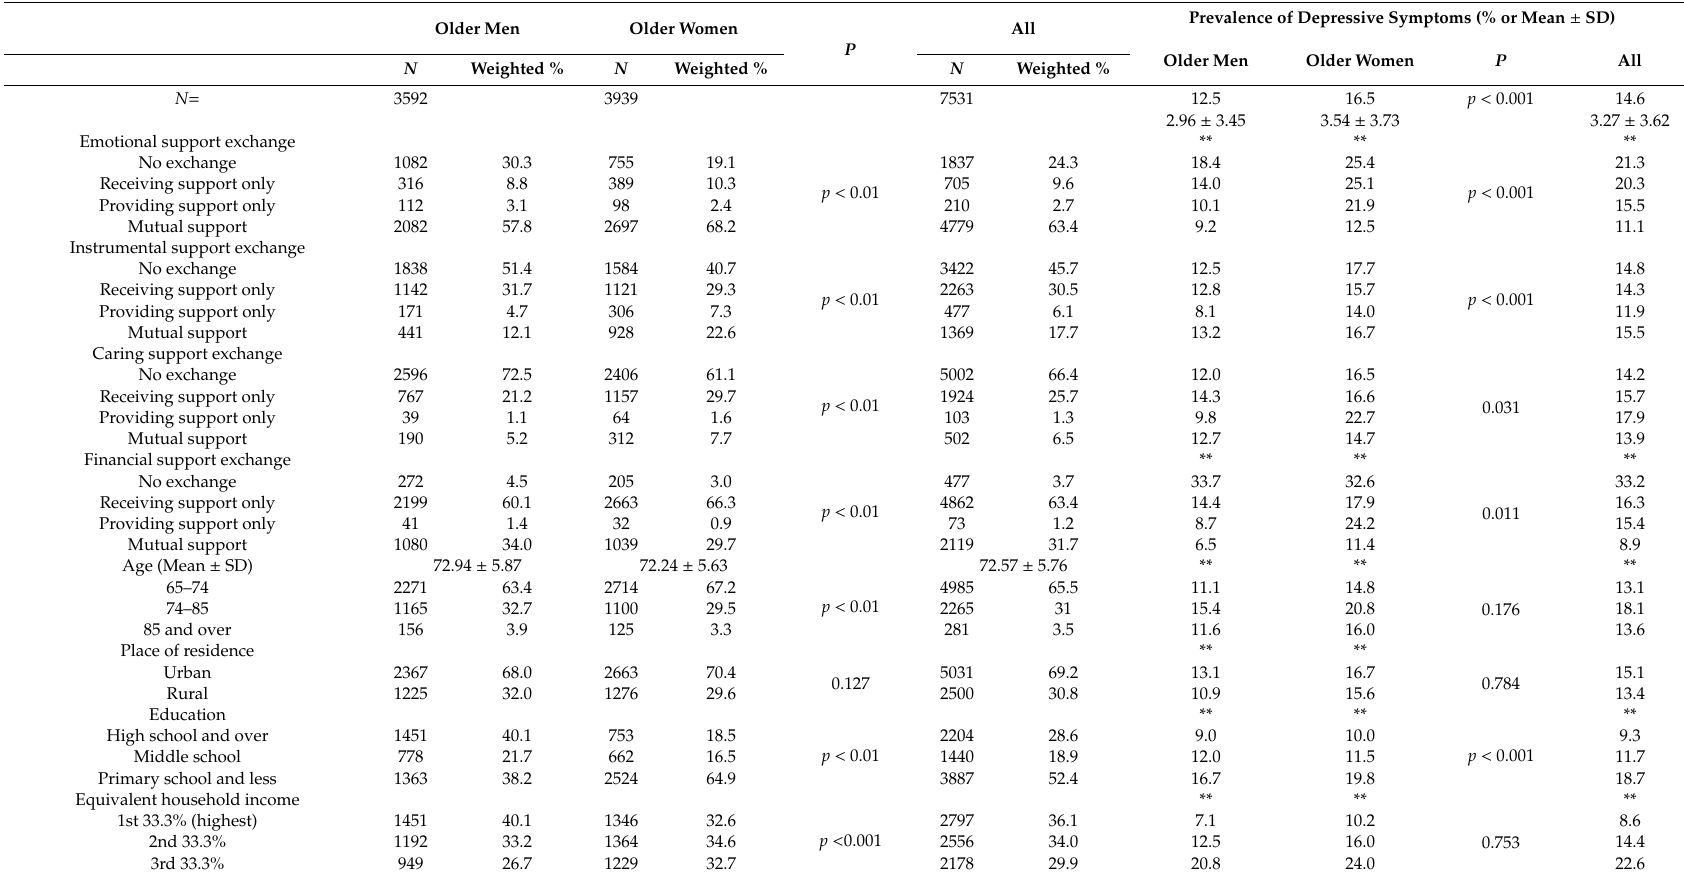
Table 1. Distribution of intergenerational social support exchange and prevalence of depressive symptoms among older men ( n = 3592) and older women ( n = 3939) in the 2017 Korean Living Profile Survey of Older